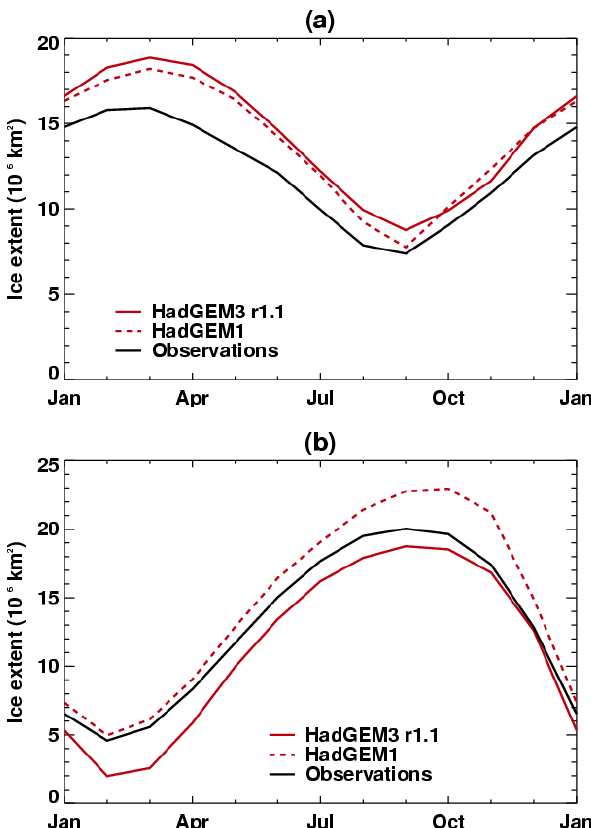
Fig. 14. Seasonal cycle of sea ice extent (10 6 km 2 ) for years 21 to 30 of HadGEM3 r1.1 (red line) and HadGEM1 (red dashed line) together with the HadISST observational data set values (Rayner et al., 2003) averaged over the period 1980–1999 (black line) for (a) Northern Hemisphere; and (b) Southern